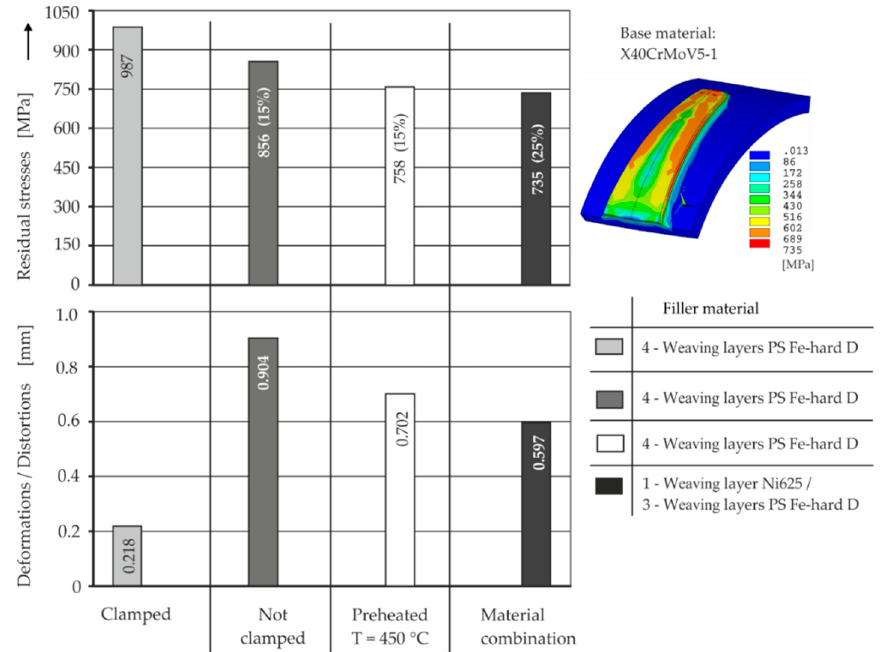
Figure 10. Using of material-technological means for minimization of residual stresses/deformations at additive plasma deposition-welded tool